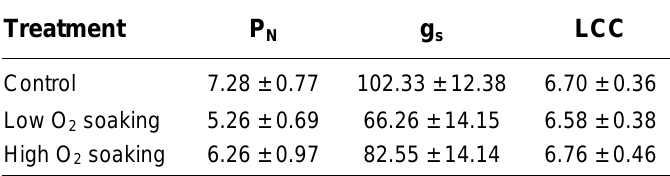
No significant differences were found among treatment groups using one-way ANOVA to test for the effect of soaking treatment on measured variables ( p = 0.256 for P N , p = 0.190 for g s , and p = 0.952 for